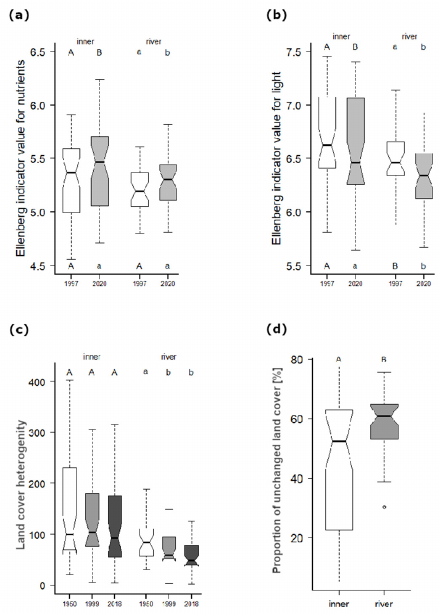
Figure A2. Changes and differences in the ( a ) Ellenberg indicator value (EIV) for nutrients, ( b ) EIV for light, ( c ) land-cover heterogeneity and ( d ) proportions of unchanged land cover (1950–2018) per grid cell within both the first (1997) and the second floristic survey (2021); or three land-cover searched periods (1950, 1999 and 2018) separated into inner (n = 44) and river (n = 34) group cells (see Methods). The letters above boxes (in (a) and (b)) indicate the results of pairwise t-tests between surveys within each group, while the letters below boxes show the results of non-pair t -tests between the groups. However, the letters above the land-cover heterogeneity boxes ( c ) show results based on the Friedman test, and when significant ( p < 0.001), the post hoc Wilcoxon pairwise test with a Bonferroni correction ( p < 0.01) was applied for the three periods: 1950, 1999 and 2018. Differences between proportions of unchanged land cover ( d ) were assessed using ANOVA repeated measures analysis (if p < 0.001, then Tukey’s post hoc tests followed). Whiskers indicate the non-outlier range with the median as the middle; boxes represent 25–75%